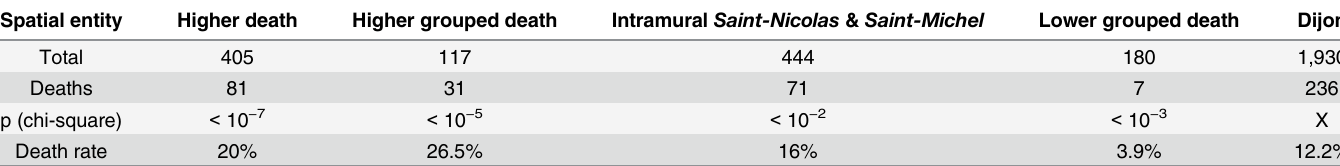
Table 5. Excess deaths in the northeast of intramural Dijon in 1428.